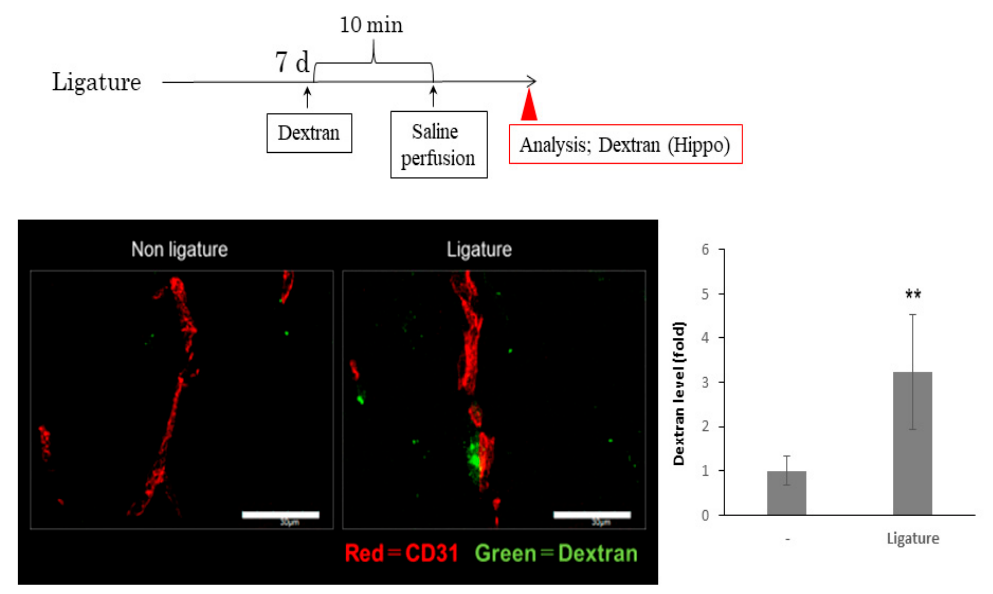
Figure 6. Ligature-induced PD increases the blood brain barrier permeability of dextran in the hippocampus. Ligature was placed for 1 week and then 3-kDa dextran was injected intravenously 10 min before saline perfusion. Representative image of extravascular dextran (green) is shown. The vessel was labeled with CD31. Bar = 30 μ m. Bar graph shows the ratio area of extravascular dextran (mean ± SE, n = 18–20/group). ** p < 0.01, significantly different from the control, Student’s t- test.